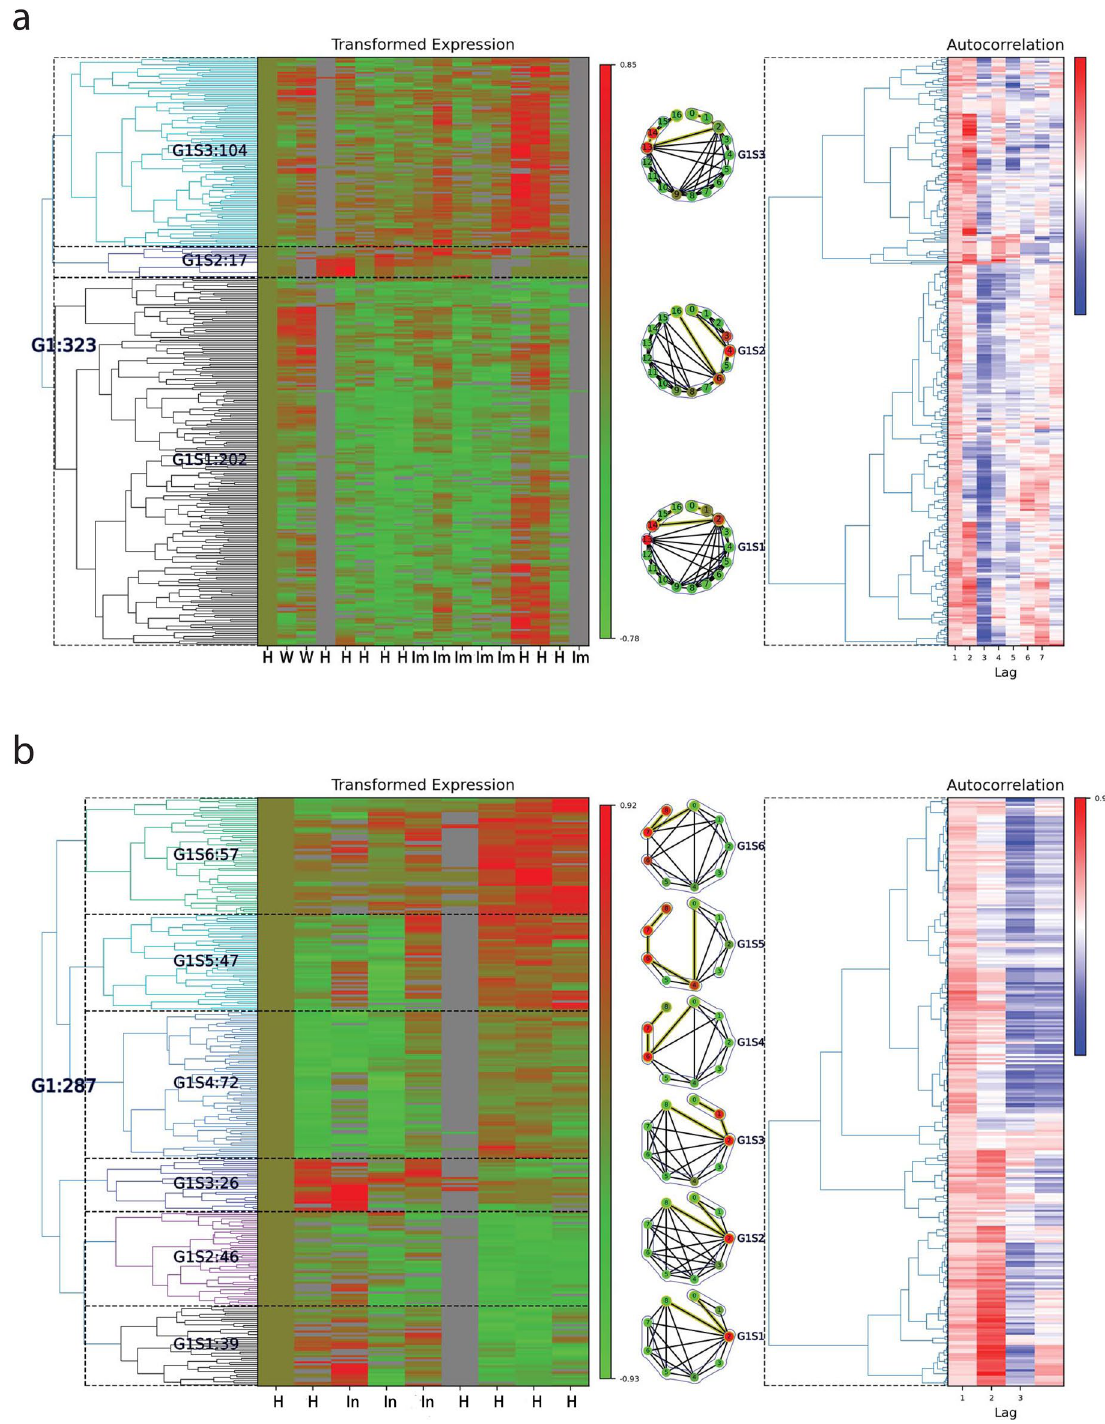
Figure 3. Single individuals’ multiomics clusters. Two examples of Lag 1 classification outcomes are shown for ( a ) Subject ZKFV71L and ( b ) Subject ZTMFN3O. In these examples the information is summarized as follows: Left panel : the cluster of groups/subgroups for Lag 1 class are shown in the visits time frame. The visit time points have been labeled by healthy status, where H: Healthy, W: Weight gain/loss, Im: Immunization, In: Infection. Middle panel : the community structure of visits within each subgroup, where the community structure is based on our visibility-graph-based community detection algorithm 24 . Right panel : corresponding autocorrelations for the time series